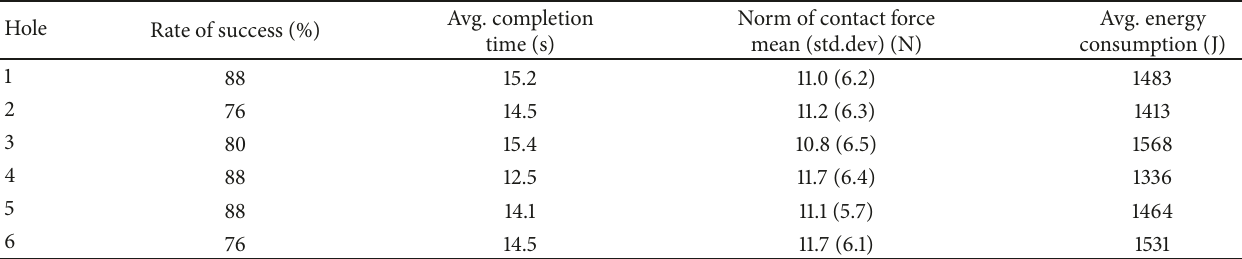
Table 3: Result comparison of insertions for different tolerance fit or